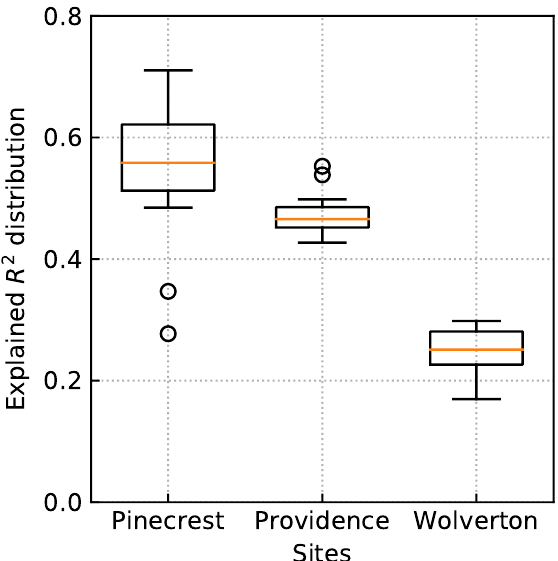
Figure 5. R 2 distribution of the trained Elastic Net model over three sites that calculated by predicting the total precipitation using the vegetation